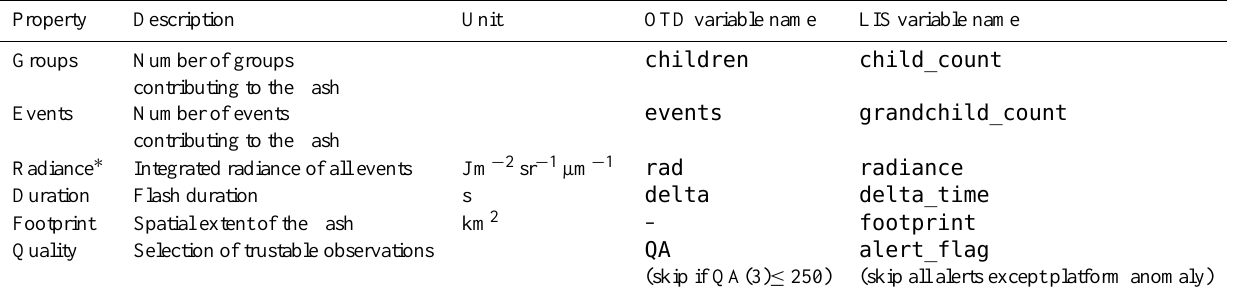
Table 1. Investigated flash properties and the respective filed names in the hdf data files provided by NASA.